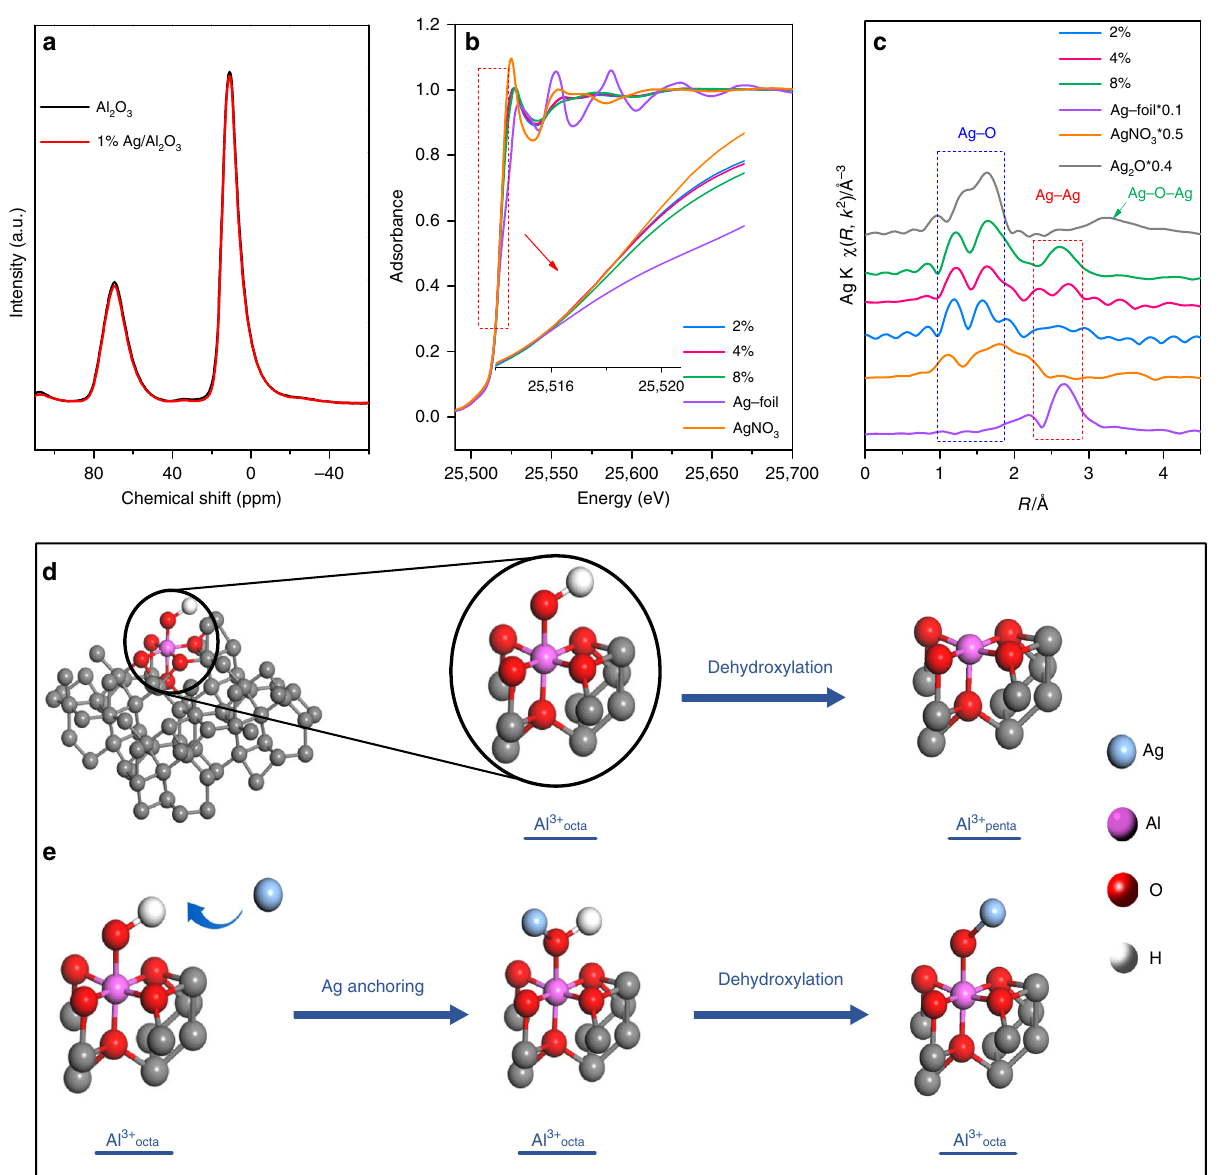
Fig. 3 27 Al NMR and XAFS characterization of Ag/nano-Al 2 O 3 and analysis of Ag anchoring. a Normalized 27 Al MAS NMR spectra of nano-Al 2 O 3 and 1 wt% Ag/nano-Al 2 O 3 . b , c Ag-K edge XANES and EXAFS spectra of standard samples and Ag/nano-Al 2 O 3 with different Ag loadings (2, 4, 8%) (Fourier transform k range 2.9-14.3 Å − 1 ). d A diagram showing possible formation process of Al 3 + penta from Al 3 + octa through dehydroxylation on Al 2 O 3. e A diagram showing possible process of Ag anchoring through interaction between Ag and Al –